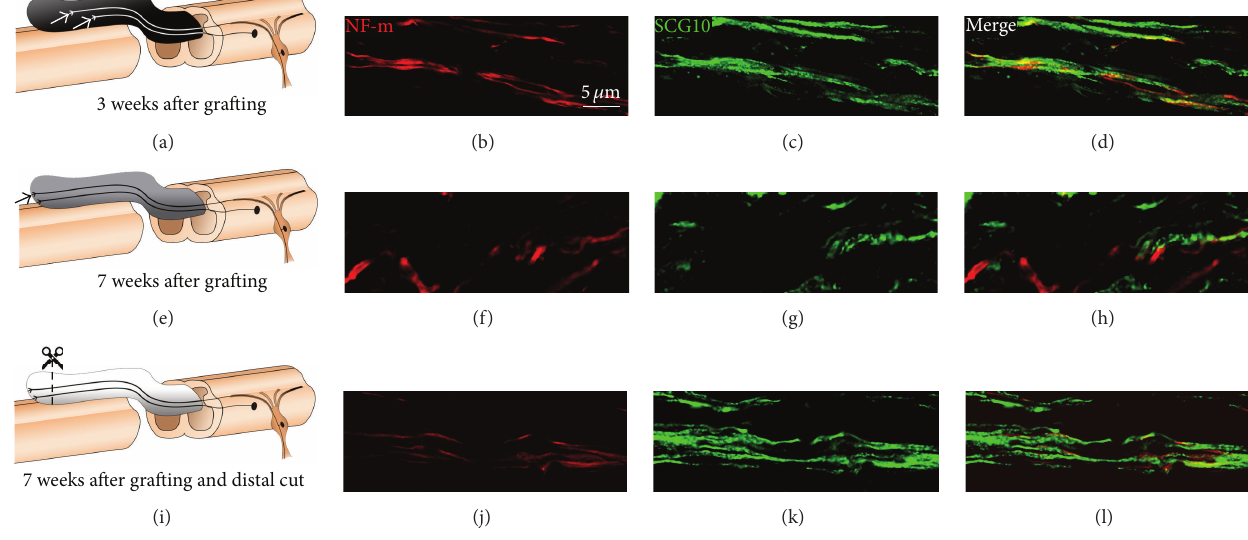
Figure 1: Experimental strategy and animal groups. All rats received a complete transection of the T12 spinal cord and immediate placement of PNGs of approximately 10 mm in length. (a) Group 1 rats received no further intervention and were euthanized at 3 weeks after grafting when the majority of axons are in active regeneration phase (arrows) and growing towards the distal end of the PNG. (b, c) show actively growing axons coimmunolabeled for NF-m and SCG10, respectively. (d) shows the merge of the two panels. (e) Group 2 rats received no further intervention and were euthanized at 7 weeks after grafting when axons had reached the unapposed distal end of the PNG (arrow) and stopped growing. (f, g) show axons “stalled” at the distal end that are coimmunolabeled for NF-m and for SCG10, respectively. (h) shows the merging of these panels. (i) Group 3 rats received a second intervention at 7 weeks after grafting when the distal end of the PNG was exposed and trimmed by 1mm (dashed line) to reinjure the “stalled” axons (i). The rats were euthanized 2 weeks later. (j, k) show reinjured axons at the distal graft end coimmunolabeled for NF-m and SCG10. (l) shows the merged image. The colors (black, gray, or white) of PNGs in (a), (e), and (i) correspond to the color of bar graphs for 3 weeks, 7 weeks, and 7-week reinjury, respectively, in Figures 2, 3, and 4. Scale bar = 5 𝜇